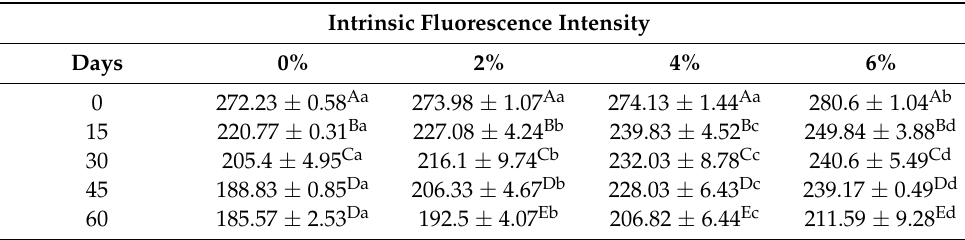
Table 2. Intrinsic fluorescence intensity of myofibrillar proteins treated with different concentrations of OVA-KC during 60 days of frozen storage at − 18 ◦ C.